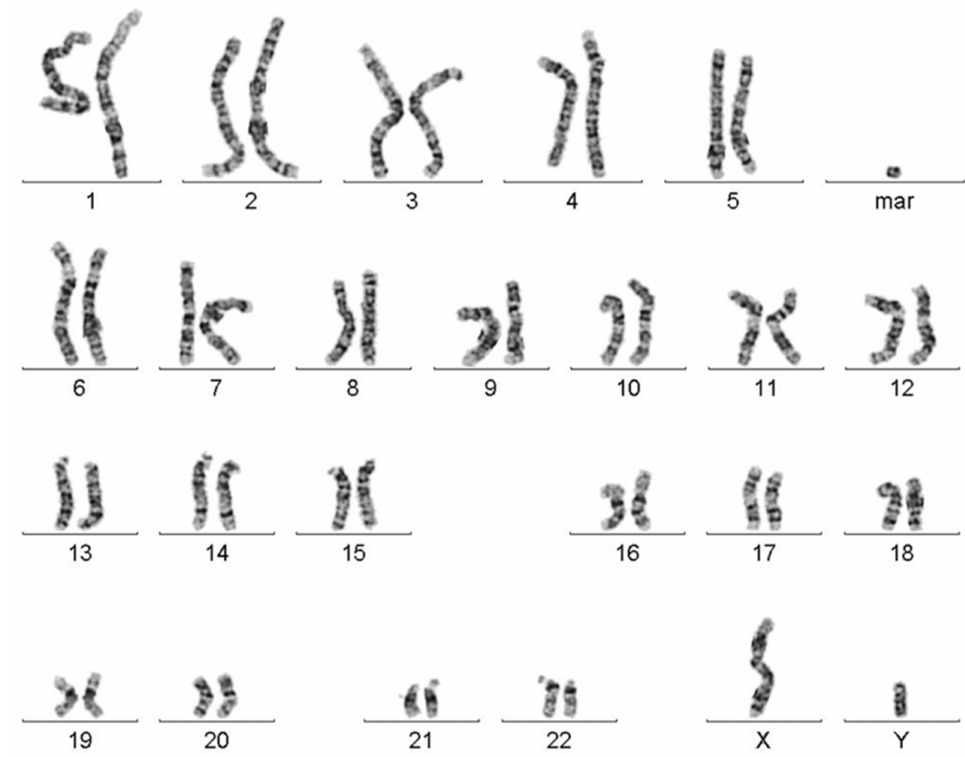
Figure 1. Karyogram after GTG-banding chromosome analysis revealed the presence of a marker chromosome (mar) in ~55% of the analyzed cells.